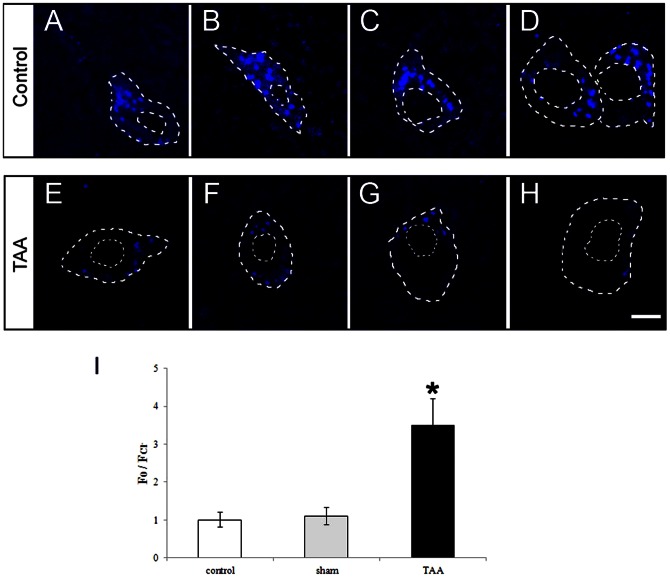
Enhancement of intracellular chloride concentration ([Cl−]i) following TAA treatment.(A–H) Results of confocal microscopic images of a single neuron within the SNr loaded with the chloride indicator dye MQAE from normal controls (A, B, C and D) and TAA-treated mice (E, F, G and H). The white circles illustrate the area from which the mean fluorescence intensity was obtained. Background subtraction removed most of the pericellular fluorescence as well as the fluorescence originating from the nucleus. All cell sections with intact perimeters were evaluated. The fluorescence is inversely proportional to the Cl− concentration. (I) The corresponding [Cl−]i levels were shown as bar graphs. * P<0.05 vs normal controls. Bars in A–H = 10 µm.